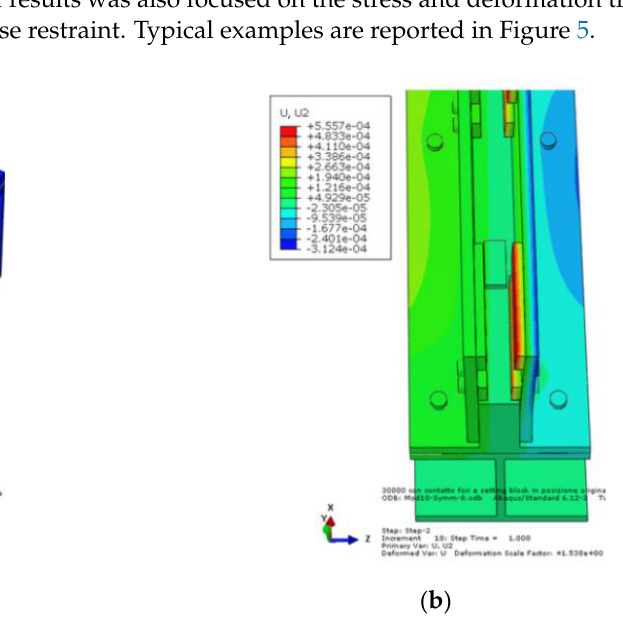
Figure 5. Example of deformation and parameters for the base restraints under lateral loads, as obtained from the Refined FE numerical model (ABAQUS): ( a ) out-of-plane and ( b ) vertical deformations (glass panel and mesh hidden from view, legend values in m).